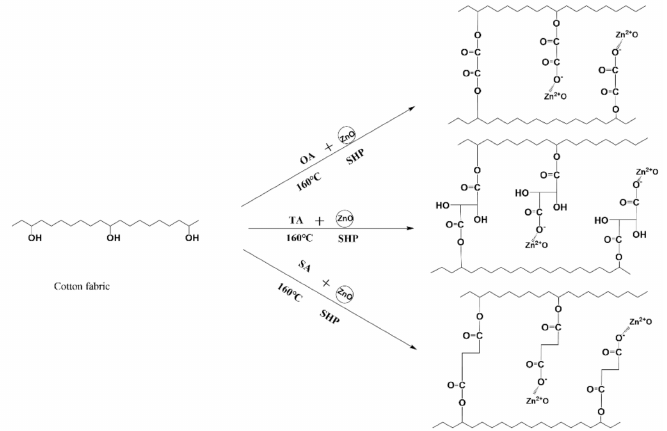
Figure 5. Schematic diagram of the cross-linked structure of OA, TA, and SA with cellulose chain and linkage of ZnO and OA, TA, and